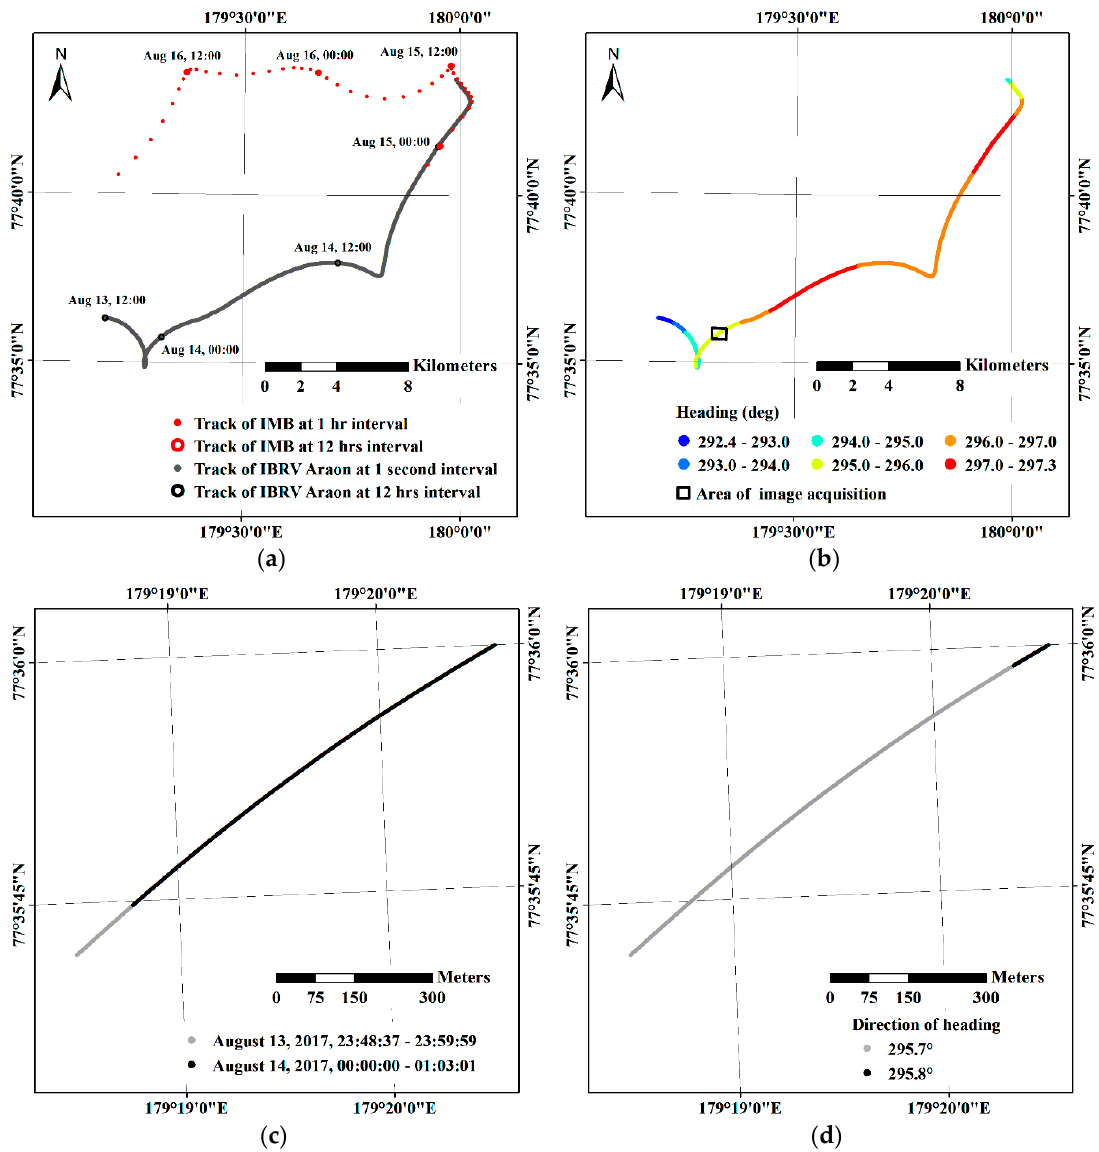
Figure 5. Trajectory of the main ice in the study area: ( a ) an overview of the tracking record from 13 August to 16 August 2017; ( b ) heading information of the IBRV Araon while anchored to the main ice; ( c ) detailed tracking record from the IBRV Araon during the helicopter-borne image acquisition; and ( d ) detailed heading information of the IBRV Araon during the helicopter-borne image acquisition.